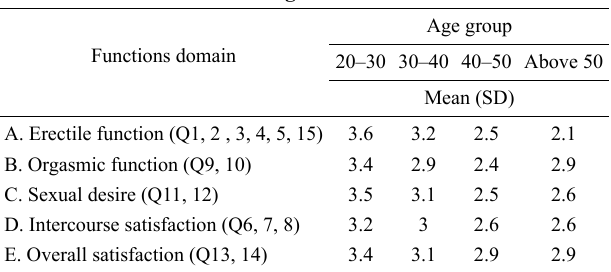
Table 2. Age and